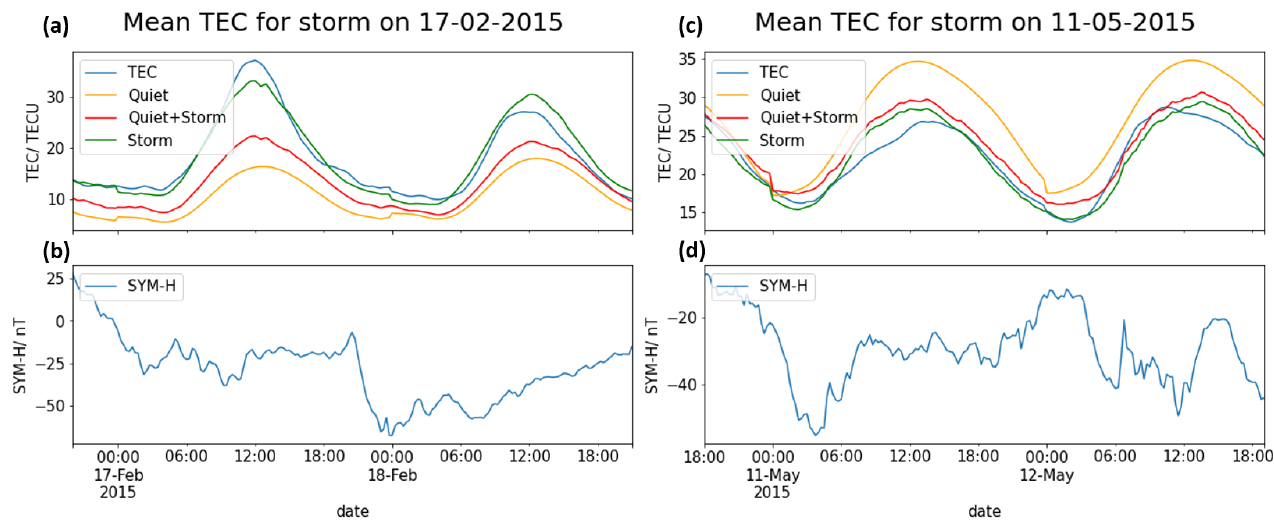
Figure 10. In the top panel is the UQRG TEC (blue curve) plotted together with the predicted TEC by the quiet-time model (orange curve), storm-time model (green curve) and the storm-time model coupled with the quiet-time model (red curve) for a geomagnetic storm on 17 February 2015 ( a ) with the SYM-H index plotted at the same time ( b ). The same is plotted for another storm that occurred on 11 May 2015, shown in ( c ) together with the corresponding SYM-H index ( d